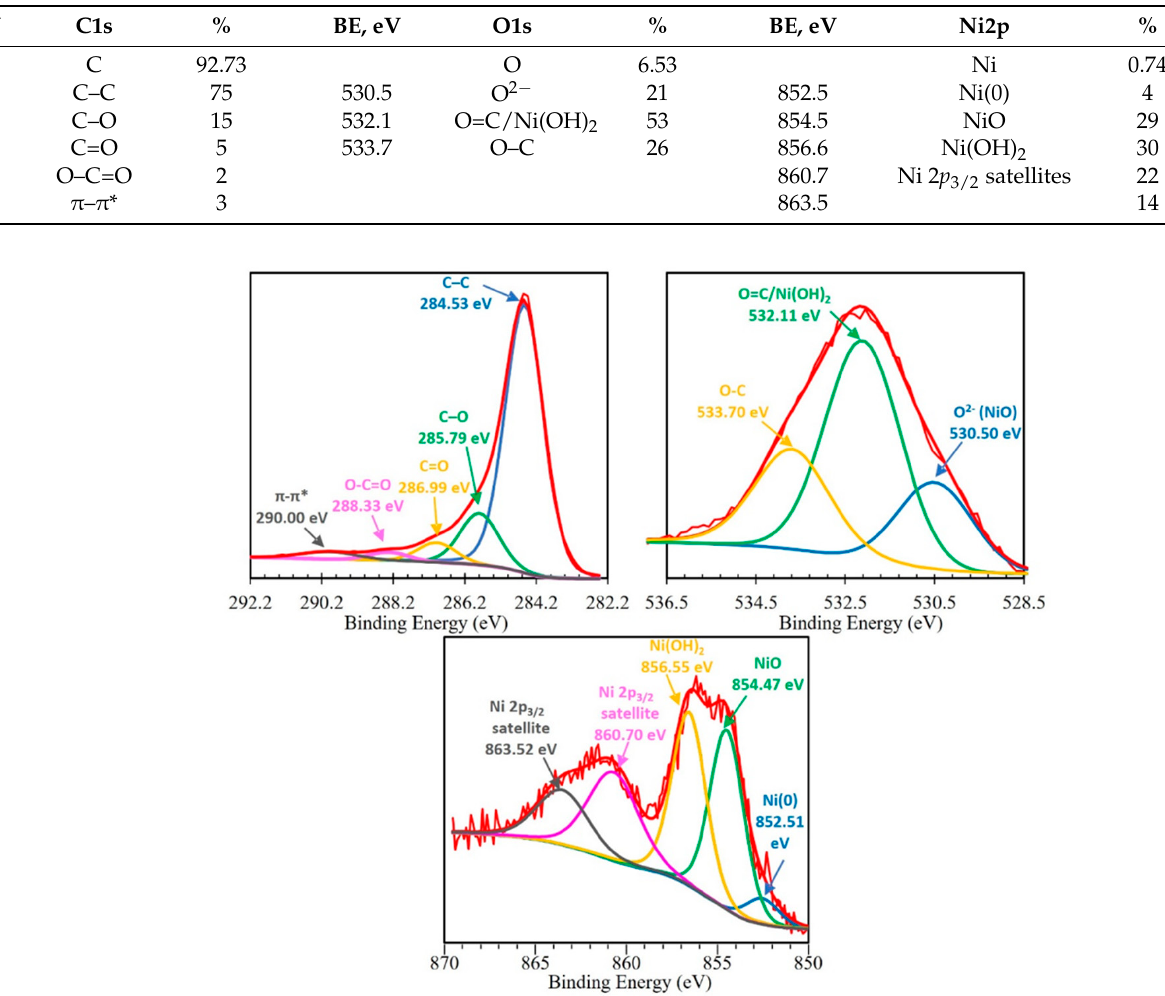
Figure 3. C1 s , O1 s and Ni 2 p core-level spectra of TPNi.